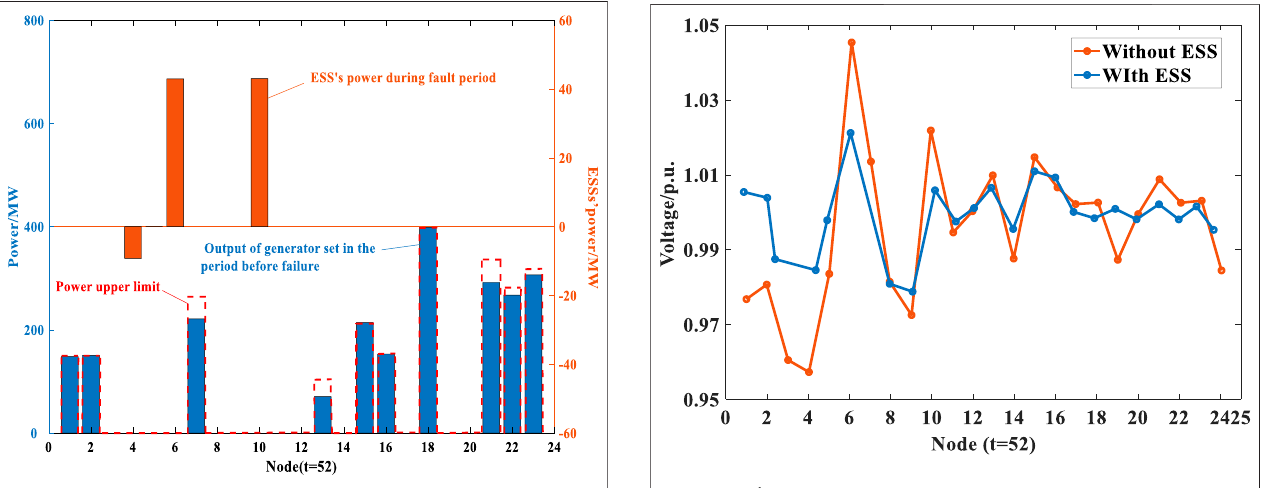
Frontiers in Energy Research |